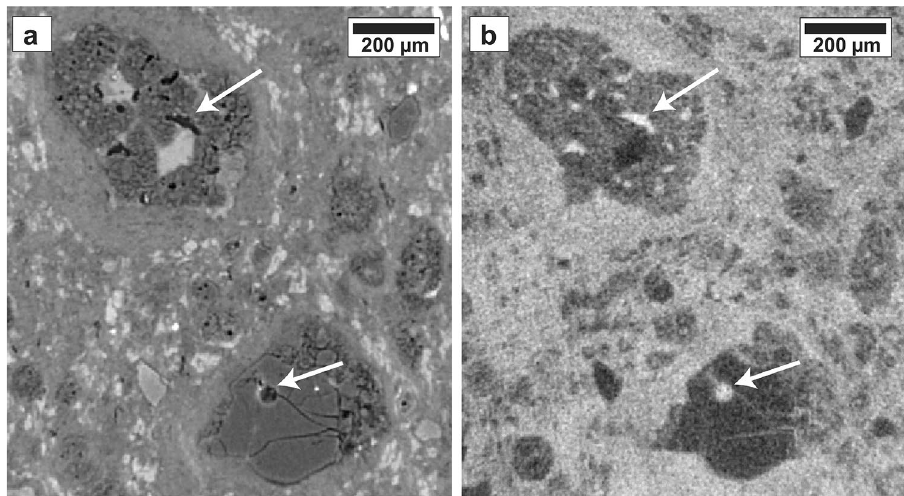
Figure 2. Detail of slice 420 shown in Fig. 1. ( a ) Air scan ( b ) Xe scan—Air scan (i.e., relative amount of infiltrated xenon). White arrows indicate large interior chondrule pores that infilled with xenon and are therefore not isolated. Their mottled appearance in ( a ) also indicate that they are partially filled with a low- density material. The largest, circular pore (bottom white arrow) measures approximately 40 µm across. The xenon infiltration image ( b ) also highlights fine fractures within the bottom chondrule and areas of lower xenon penetration (i.e., lower porosity) within the top chondrule.